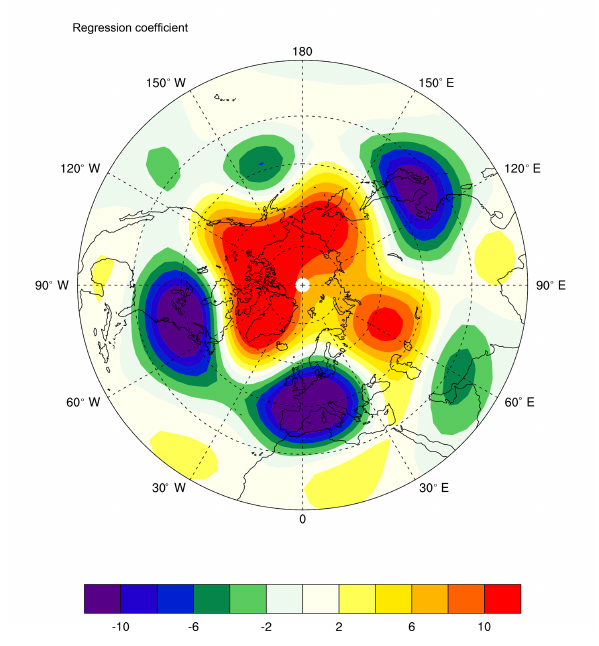
Figure 9. Annual mean geopotential height regressed against the SST over the North Atlantic during 5.0–3.0ka derived from the TraCE-ALL run, after 31-year running mean application.